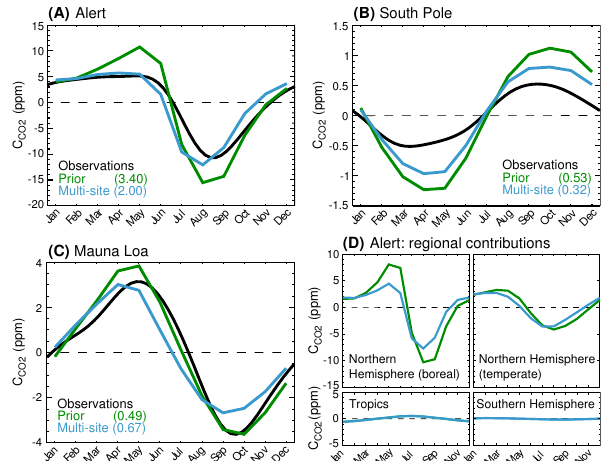
Figure 6. Detrended mean seasonal cycle of the atmospheric CO 2 concentrations at (a) Alert, (b) South Pole and (c) Mauna Loa lo- cations during the 1989–2009 period: the optimization-independent concentration records (black) are compared to simulations where the biospheric contribution is calculated using the ORCHIDEE model with the default (green) and multisite (blue) parameteriza- tions, and the model–data RMSD given between brackets. (d) Re- gional contributions to the mean seasonal cycle simulated at